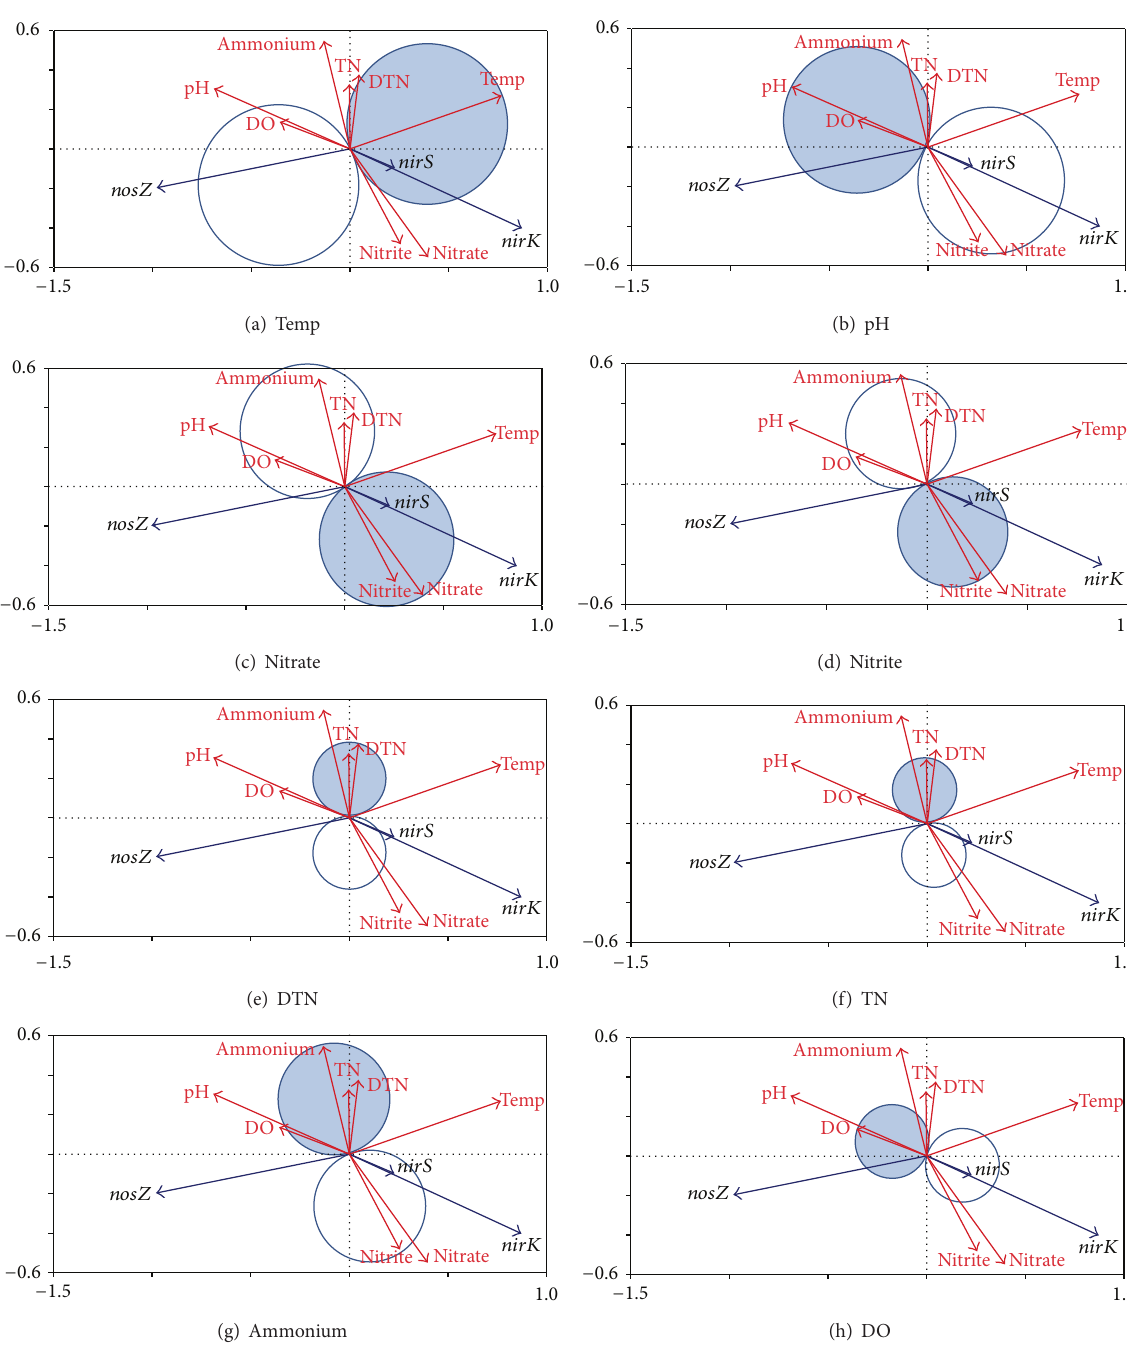
Figure 3: Redundancy analysis 𝑡 -value biplots of environmental factors Temp, pH, nitrate, nitrite, DTN, TN, DO, and ammonium and abundance of nirK , nirS, and nosZ